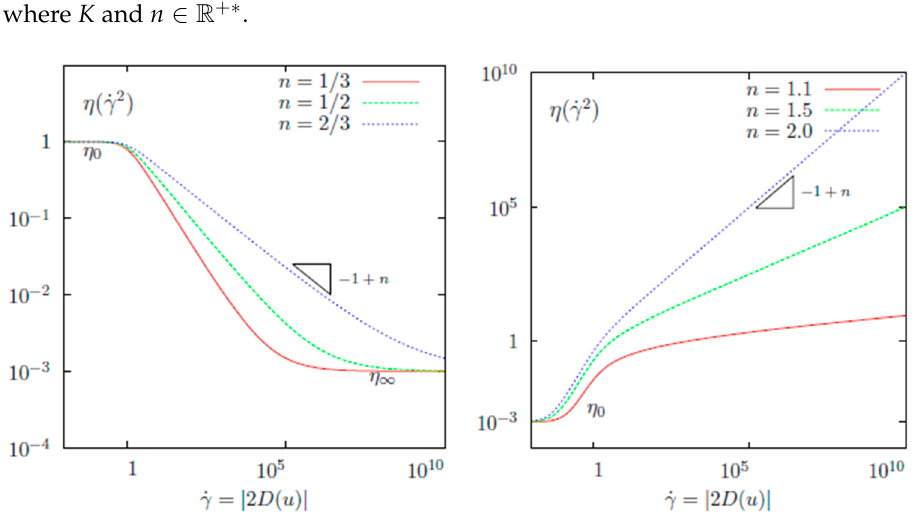
Figure 1. Quasi-Newtonian fluid flow, Carreau law viscosity for n < 1 ( left ) and n > 1 ( right ). Note that, when n = 1, both the power law and Carreau law are reduced to a Newto- nian fluid model with constant viscosity. When n < 1, the viscosity is decreasing with the shear rate and the fluid is said to be “shear thinning” or “pseudoplastic”. The tensor norm and the shear rate are defined as follows (see [14], Definition 1.9 for more precise details).